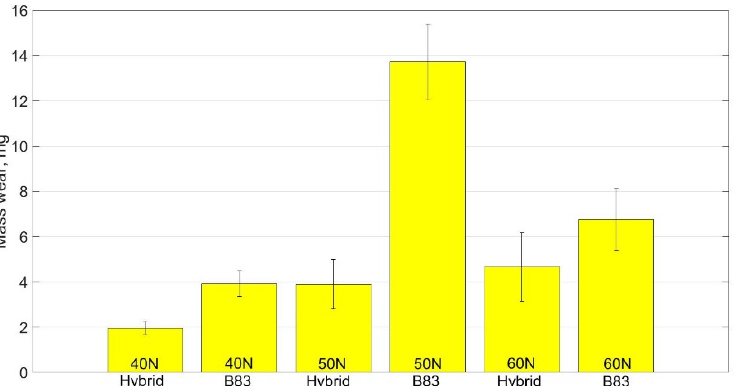
Figure 8. Mass wear of the hybrid material and B83 babbitt with respect to different loads of 40, 50, and 60 N and a distance of 418 m under dry friction conditions at room temperature.